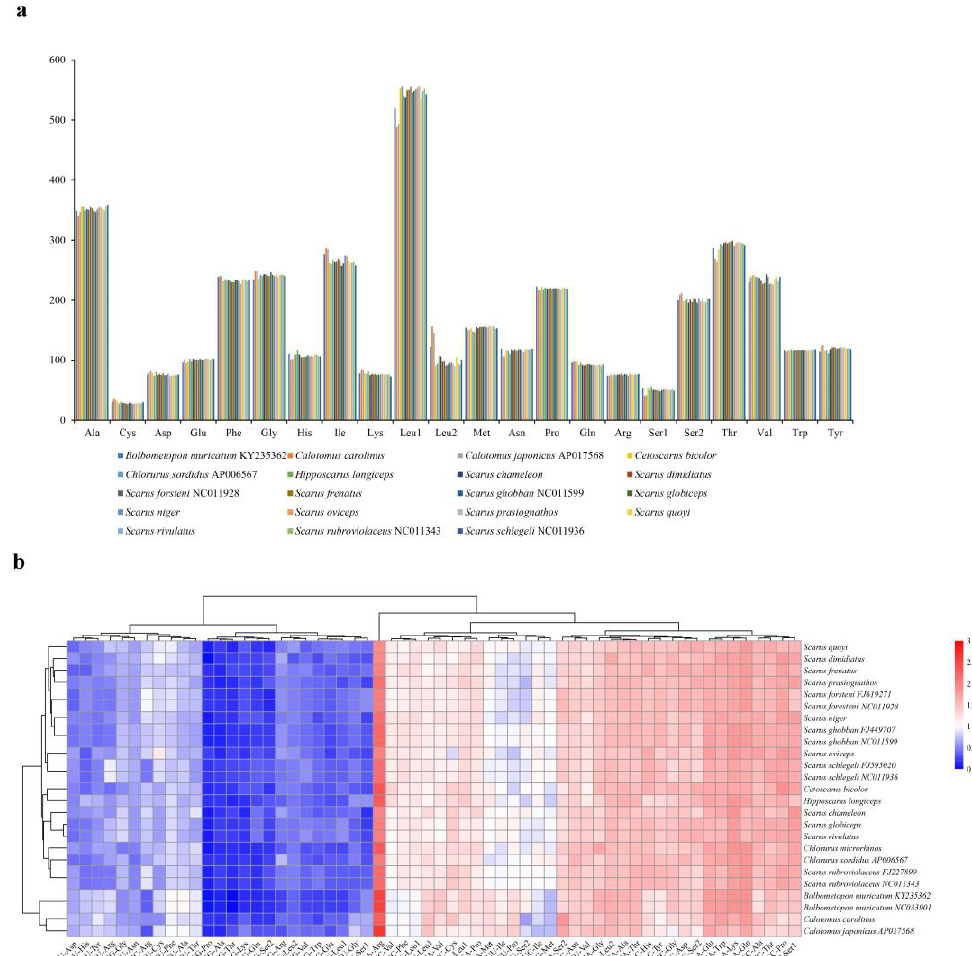
Figure 3. ( a ) Amino acid frequency in the parrotfish mitogenomes. ( b ) Heatmap based on the relative synonymous codon usage (RSCU) in the parrotfish mitogenomes.